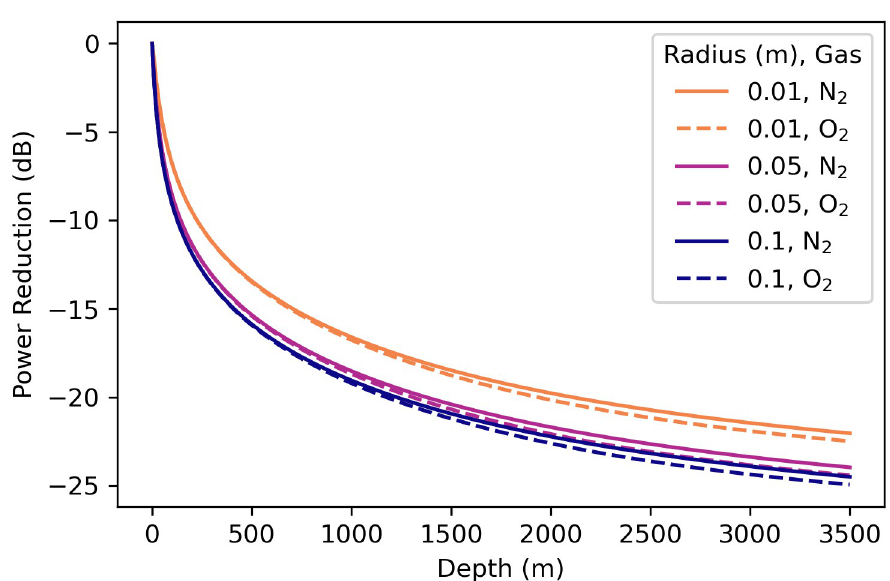
Fig 8. Bubble radiated power reduction vs. depth. This is calculated as the ratio of the scattering cross-section at ( d )/ σ (0) for a 1.5˚C constant temperature, 35.0 g/kg constant salinity depth to the surface scattering cross-section σ s s depth profile. The decibel power reduction at depth d is given by 10log 10 [ σ s ( d )/ σ s (0)]. See section 10 in S3 and S4 Files for the calculations used for this plot.